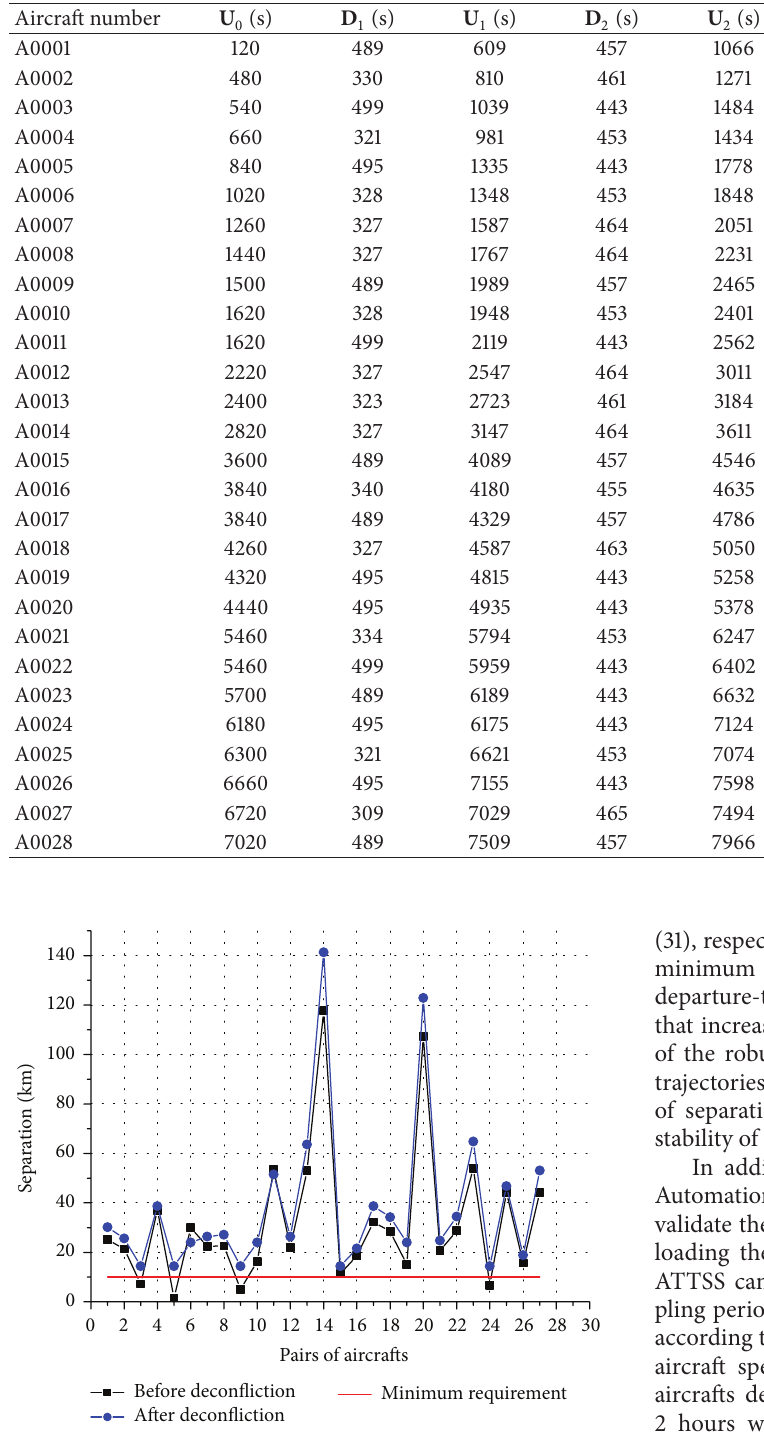
Table 4: Parameters of synthesized converging and following conflict-control models.